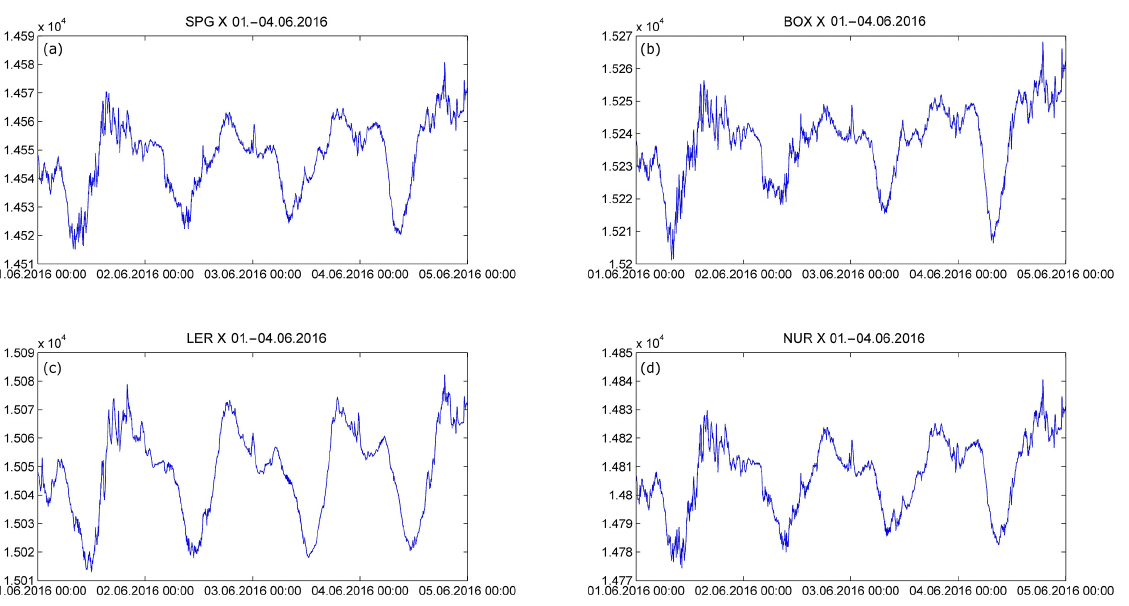
Figure 7. Minute magnetic variations of the X component during a quiet period 1–4 June 2016. Table 3. Results of comparison between the average absolute values of the magnetic field vector components and the model values for different internal field models. CF stands for core field, and AF for the anomalous (lithospheric) field; the number after the AF in the model name indicates its spherical expansion order and degree. Model Epoch